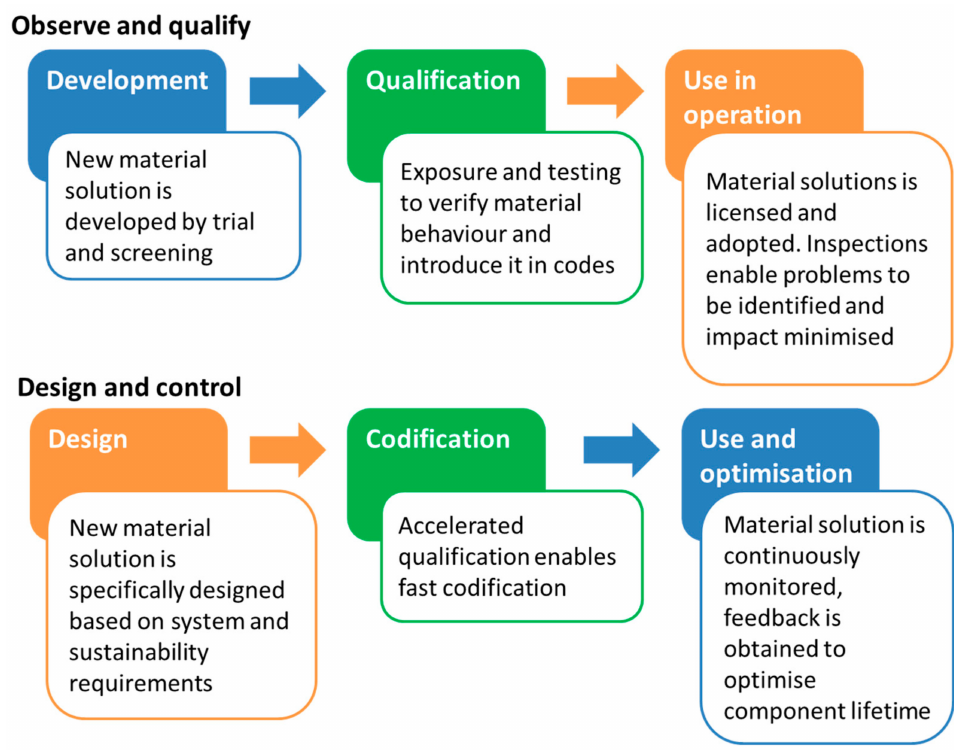
Figure 3. Schematic illustration of the “Observe and Qualify” and “Design and Control” paradigms. The colours help to show that in the latter case the point of view is inverted: material solutions are designed based on operational and sustainability